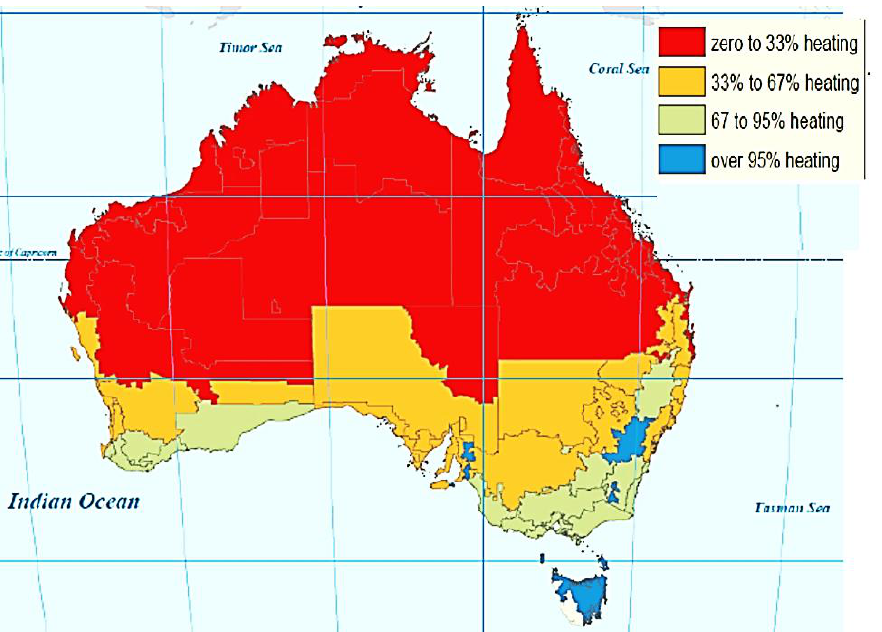
Fig. 2. Australian heating and cooling requirements of 21 °C for cooling (21CDD) and 15 °C for heating (15HDD)